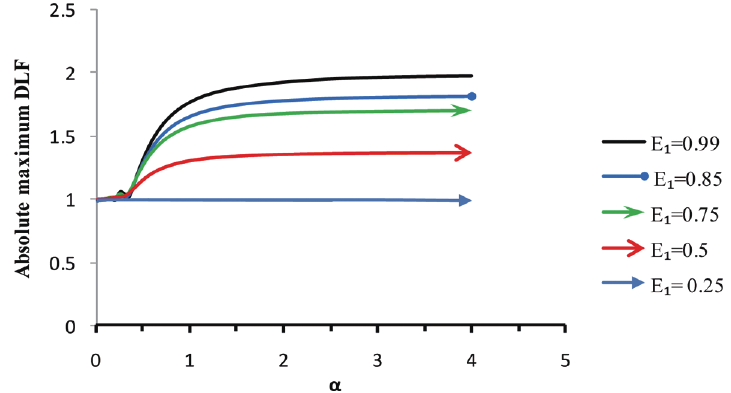
Fig. 14. The absolute maximum DLF graphs for K =